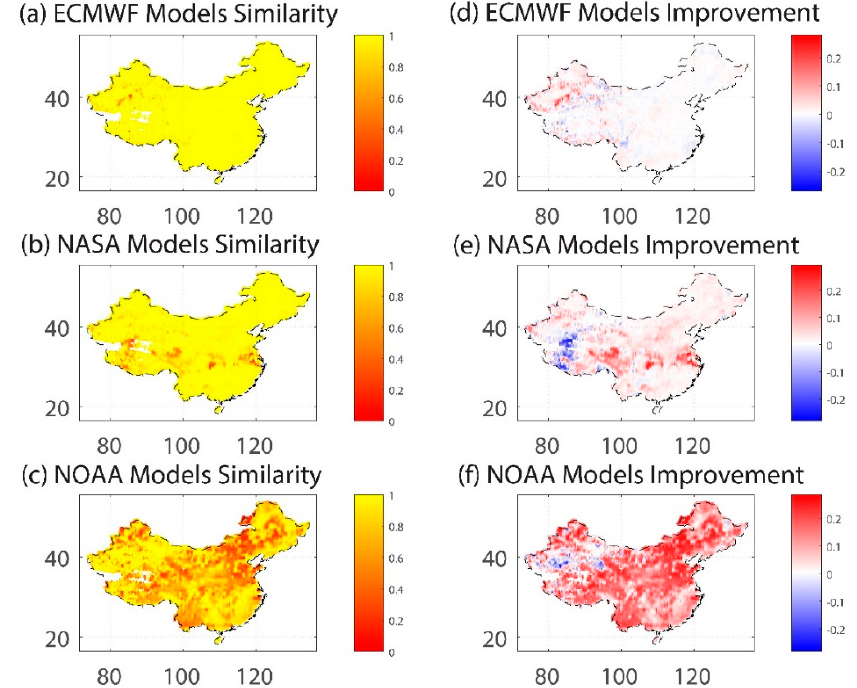
Figure 5. Similarities maps for the three LSM families ( a – c ) and their corresponding improvement maps based on TCA RMSEs ( d – f ), where red represents improvements and blue represents deterioration in quality.